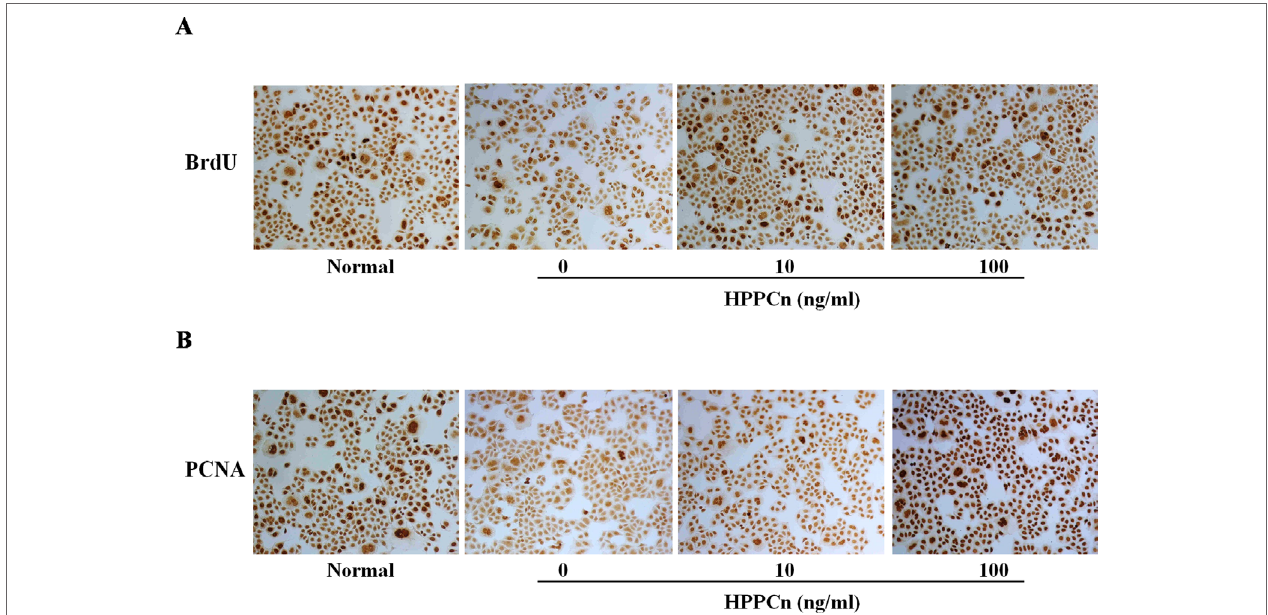
FIGURE 2 | Effects of rhHPPCn on the proliferation of SMMC7721 cells treated with CCl 4 (100×). The BrdU incorporation and the PCNA expression in SMMC7721 cells treated with different concentrations of rhHPPCn after 10 mmol/L CCl 4 injury detected by IHC. (A) The incorporation of BrdU in SMMC7721 cells treated with different concentrations of rhHPPCn after 10 mmol/L CCl 4 injury. (B) The expression of PCNA in SMMC7721 cells treated with different concentrations of rhHPPCn after 10 mmol/L